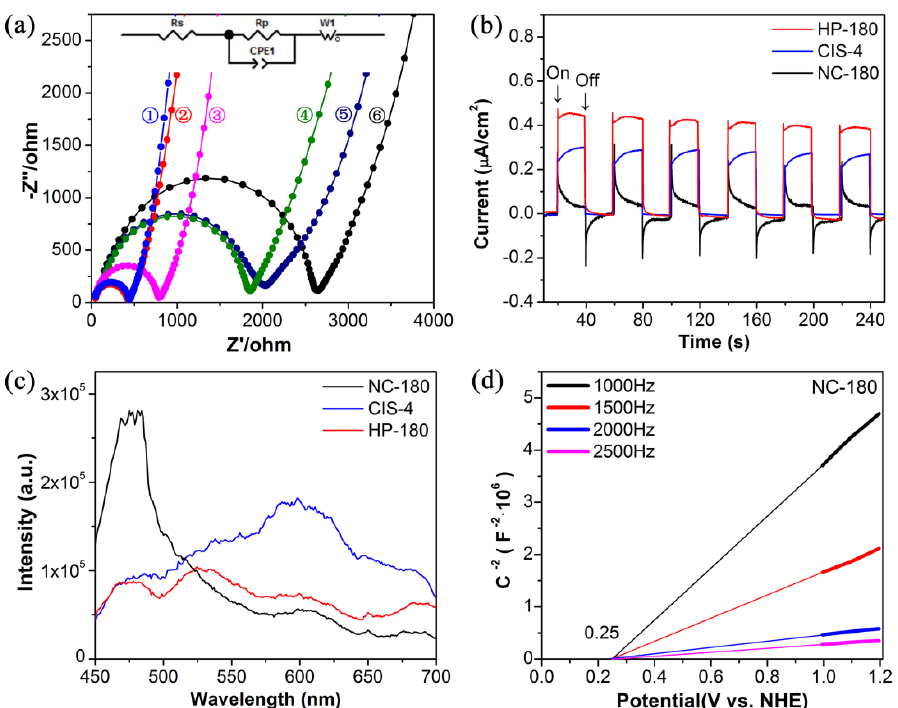
Figure 8. ( a ) Nyquist plots of ① HP ‐ 190, ② HP ‐ 180, ③ HP ‐ 150, ④ HP ‐ 120, ⑤ CIS ‐ 4, ⑥ NC ‐ 180; ( b ) transient photocurrent spectra of HP ‐ 180, CIS ‐ 4 and NC ‐ 180; ( c ) photoluminescence spectra of CIS ‐ 4, NC ‐ 180, HP ‐ 180; and ( d ) Mott ‐ Schottky plots of NC ‐ 180.